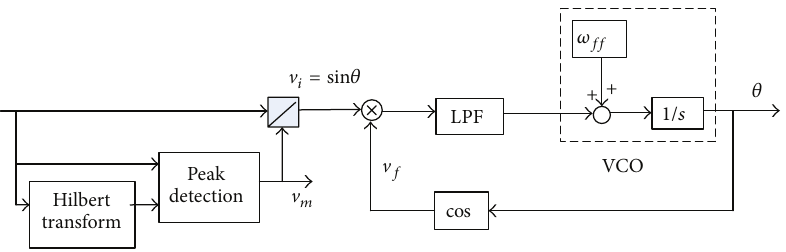
Figure 6: Block diagram of the software